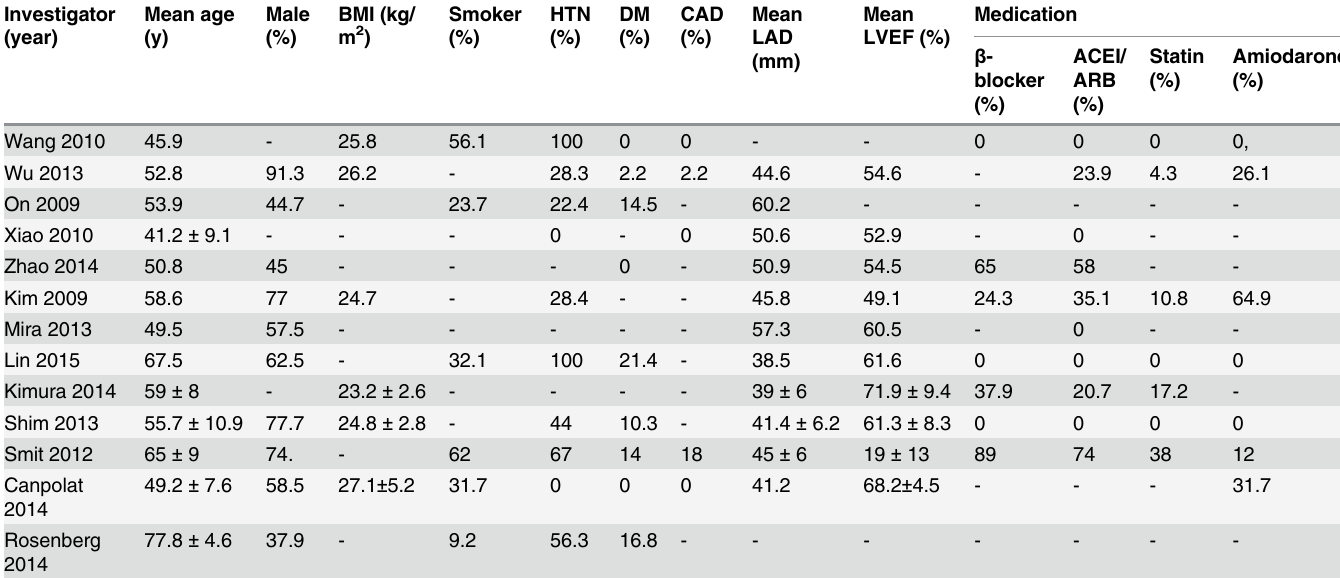
Table 2. Patients characteristics of included studies.